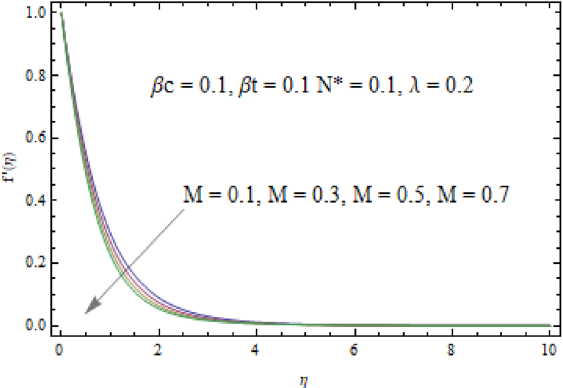
Fig. 8 Impact of N ∗ on f (cid:5) (η)